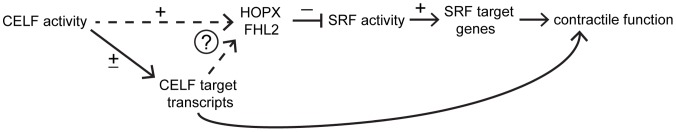
CELF-mediated alternative splicing regulates contractile function via transcriptional and post-transcriptional control mechanisms.SRF regulates the transcription of genes involved in contractile apparatus structure and function. HOPX and FHL2 bind to SRF and inhibit its ability to activate target gene transcription. We propose a model in which CELF-mediated alternative splicing regulates the SRF transcriptional program via modulation of Hopx and/or Fhl2 levels. Reduced CELF-mediated alternative splicing activity in the hearts of MHC-CELFΔ mice leads to a decrease in Hopx and Fhl2, and a complementary increase in SRF target gene expression. Over-expression of CELF1 in the hearts of MCKCUG-BP1 mice leads to an increase in Fhl2, though not Hopx, and a decrease in some SRF target genes. At this time, it is not clear whether Fhl2 and Hopx transcript levels are regulated directly or indirectly by CELF activity. In addition, CELF proteins regulate the alternative splicing of some cardiac transcripts known to encode proteins involved in contractile function, such as Ank2. Thus, the cardiac CELF-mediated alternative splicing program likely regulates contractile function both by modulating the activity of a key transcription factor that controls the expression levels of contractile genes, and by directing the production of specific variants that affect contractile performance.